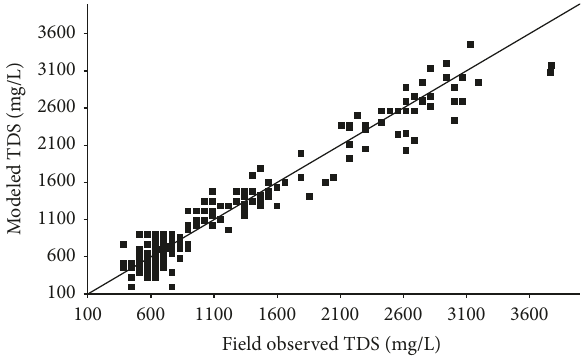
Figure 7: Scattergram of measured versus modeled TDS in